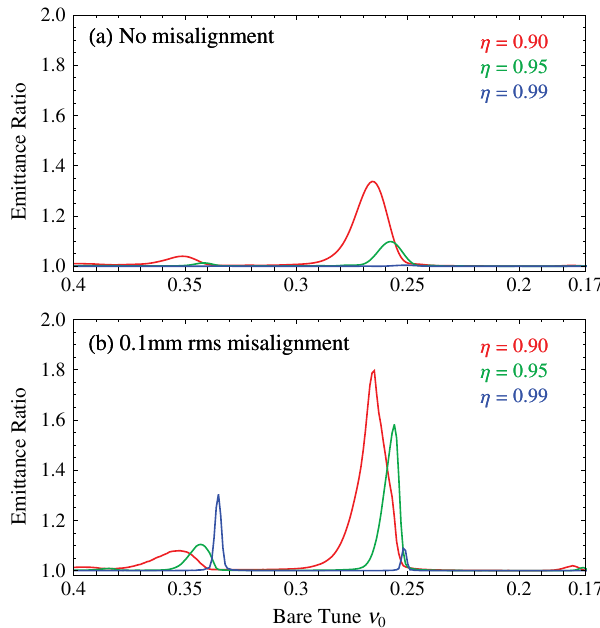
FIG. 5. Stop bands in the high density regime (multiparticle simulation results with space charge). The same systematic WARP simulations as in Fig. 4 are carried out with the Coulomb potential switched on. The ordinate represents the rate of rms emittance growth after 0.1 ms plasma storage in the LPT. The initial particle distribution is Gaussian matched to the rf quad- rupole focusing force. Three different tune depressions are considered; namely (cid:3) ¼ 0 : 99 , 0.95, and 0.9. In the upper picture, we have assumed no misalignments of the quadrupole rods. The lower picture corresponds to the more realistic case where low- order nonlinearities are considerably enhanced by 0.1-mm (rms) rod misalignments. For easy comparison with later simulation pictures, the abscissa has been reversed.